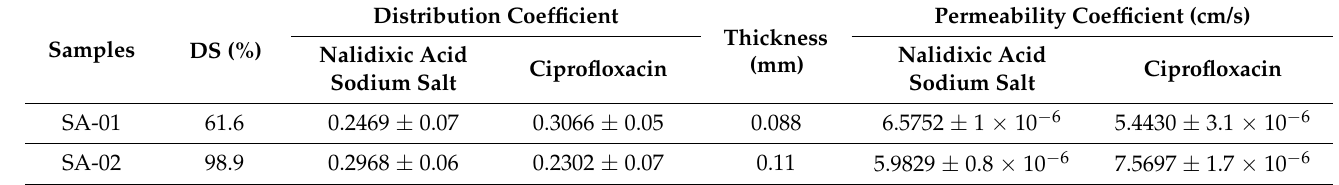
Table 4. Physicochemical properties of